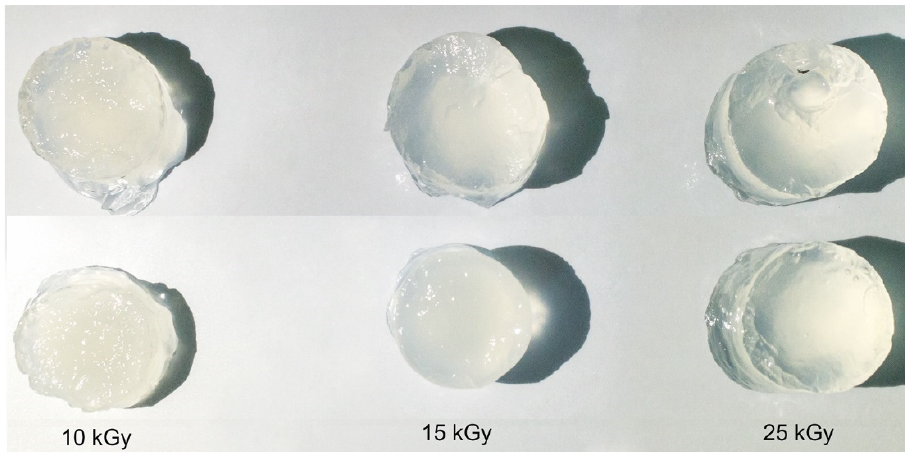
Figure 9. Digital photographs of the cross-linked hydrogels at 10, 15 and 25 kGy.